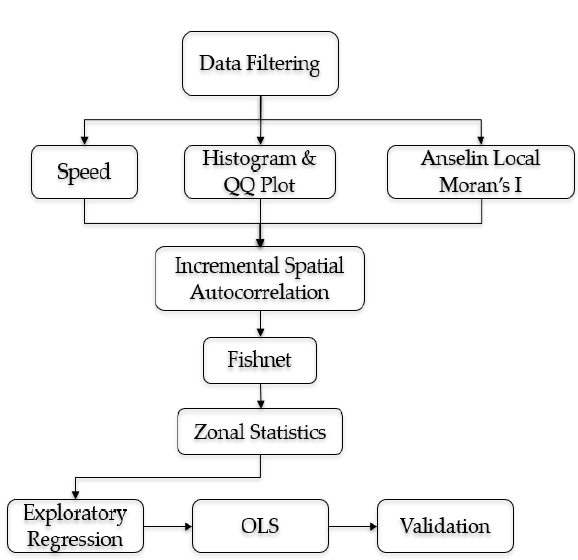
Figure 4. Yield data processing